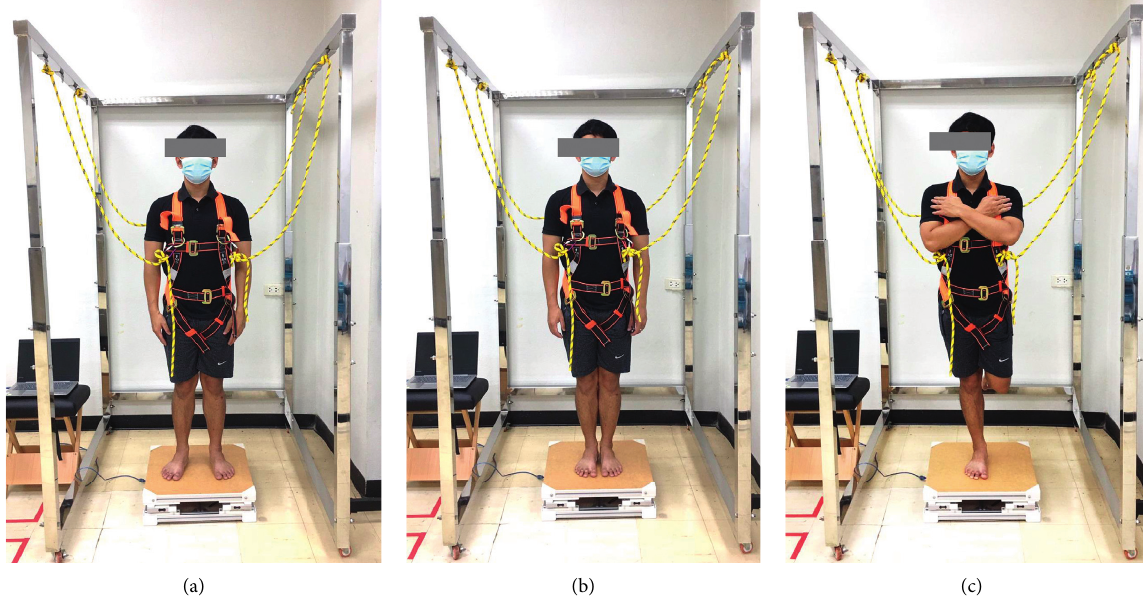
Figure 4: Standing postural stability control tests: (a) double leg stance with feet shoulder width apart, (b) double leg stance with feet together, and (c) single leg